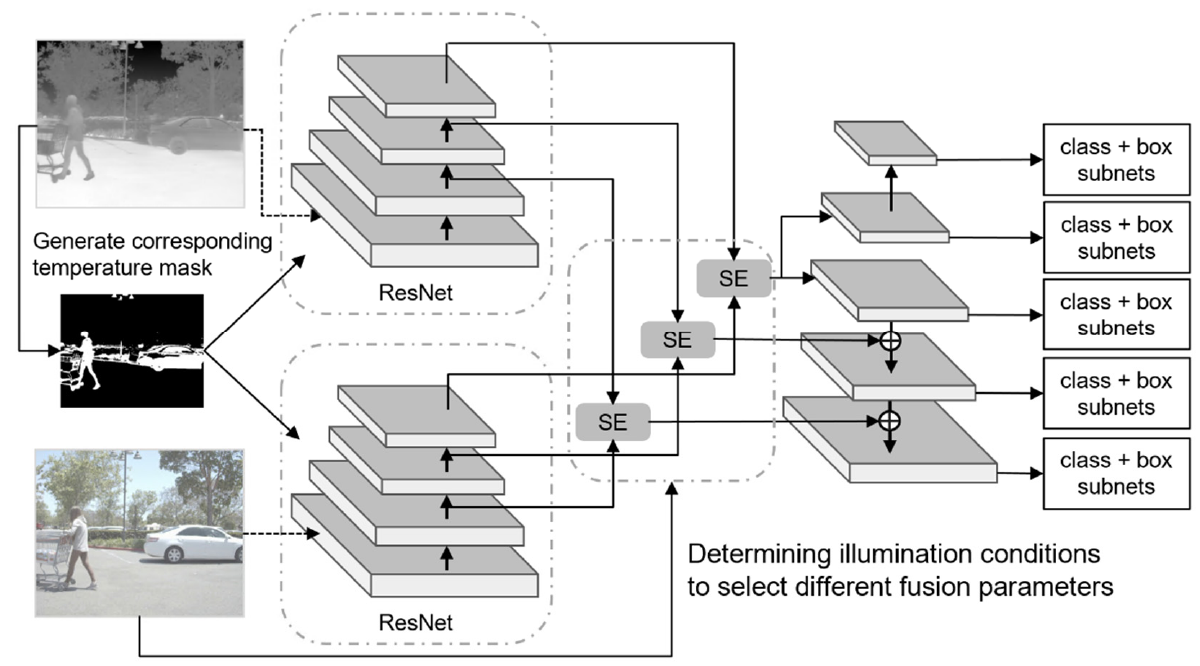
Figure 6. The schematic diagram of the model framework of the proposed model. Lin et al. proposed an improved cross-entropy (CE loss) loss function called focal loss [11]; in this function, the original CE loss is multiplied by an exponent that weakens the contribution of the easily detectable targets. This enables focal loss to successfully overcome the problem of common loss functions being swayed by a large number of negative samples under the condition of an extreme imbalance of positive and negative samples. This expression is given by Equation (3). However, the final focal loss [11] also includes the introduction of the coefficient α so that it can balance the difficult and easy samples, and its expression is given by Equation (4). The model proposed in this paper employs the smooth L 1 as the prediction frame regression loss function, focal loss as the category classification loss function, and the sum of the two as the total loss function, as given by Equation